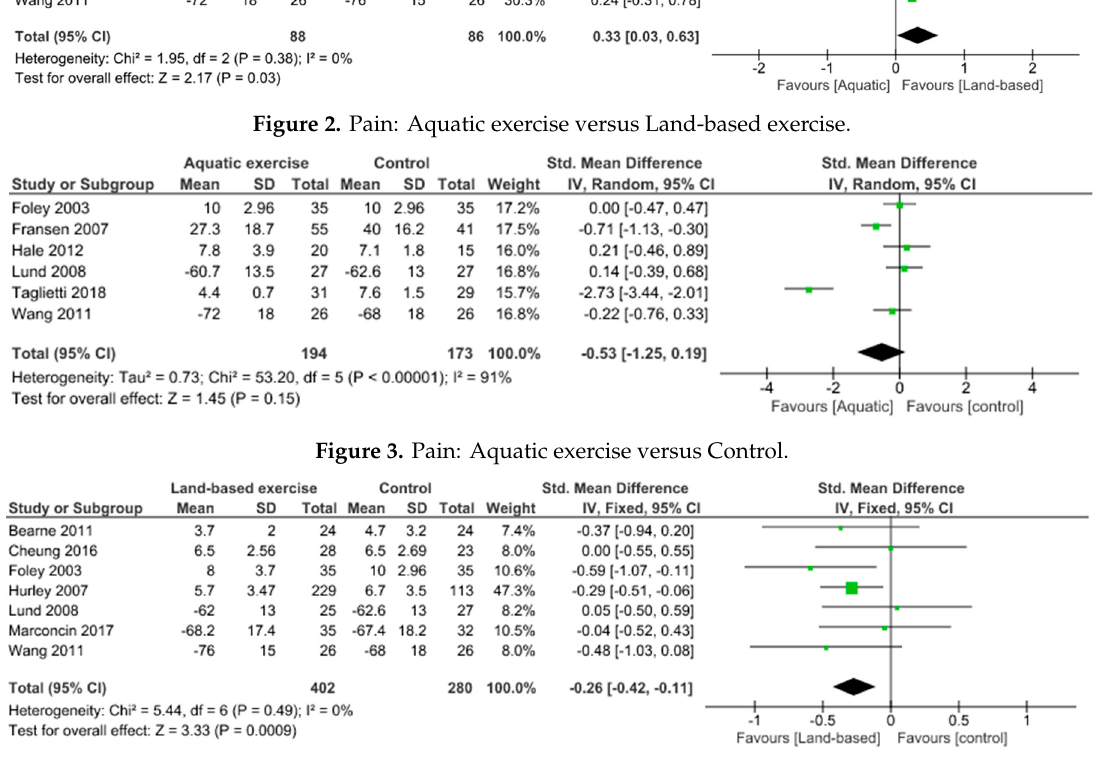
Figure 4. Pain: Land-based exercise versus